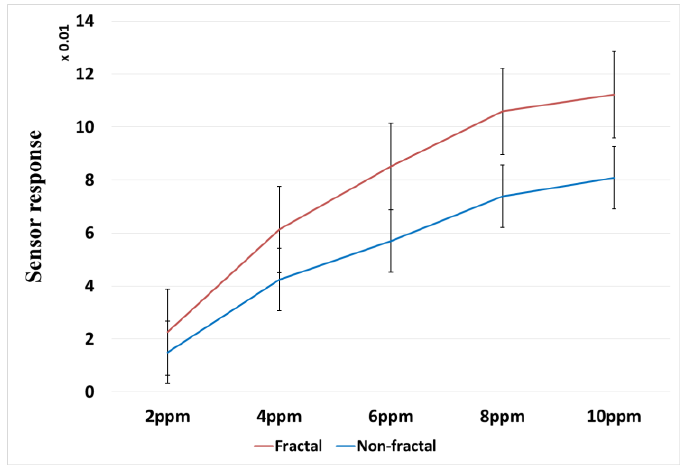
Figure 11. Curve of sensor responses to NO with standard error bars at concentration gradient.